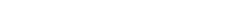
Mechanostat remodelling scheme.Change in the local density of bone for each time step, , was governed by the local stimulus (s) according to the following rules:

where  and  were the stimuli at which deposition and resorption saturation occurred respectively, and S
1 and S
2 defined the limits of the lazy zone.  was the maximum rate of change of density for each of the remodelling steps.